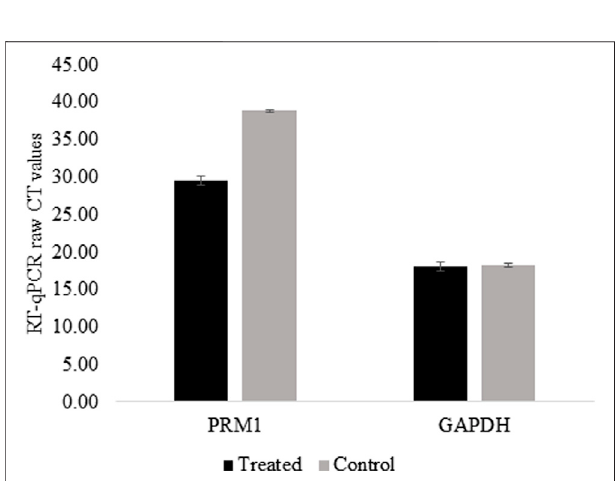
FIGURE2| PRM1expressionincontrolandtreatedHEK293TusingRT- qPCR. Raw CT values were obtained using SYBR green on BioRad CFX connect. Low CT values represent high expression of the gene. Control cells raw CTs > 38 which is considered no expression. Results were obtained from three biological replicates. Error bars represent the standard error of the